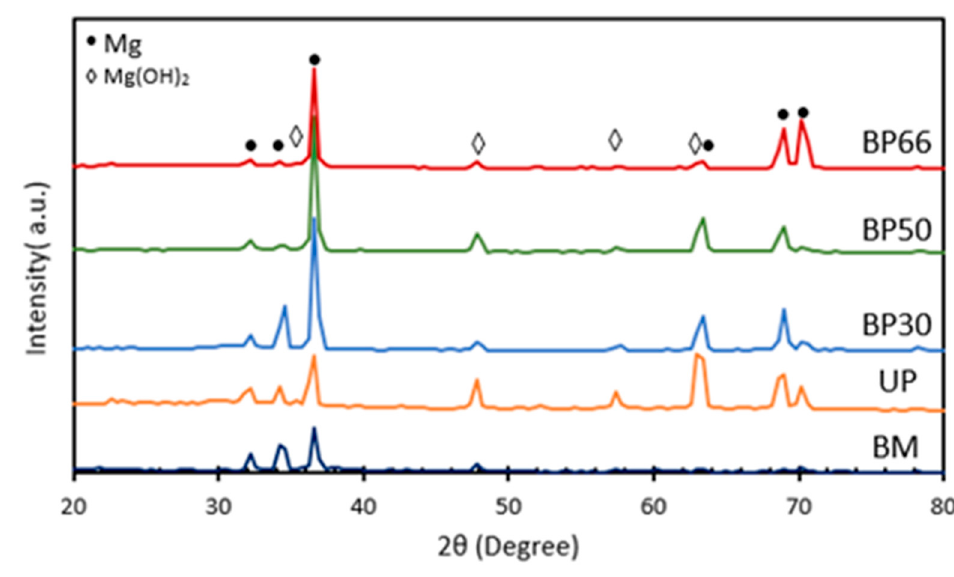
Figure 7. XRD patterns of the PEO-coated AM60 substrate after the corrosion test.